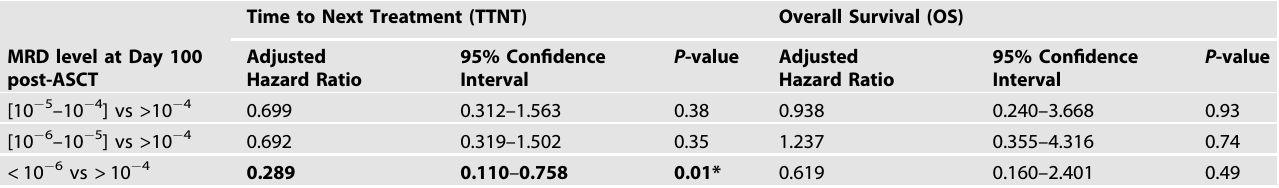
Table 2. Cox proportional hazard model for Time to Next Treatment (TTNT) and Overall Survival (OS) by Minimal Residual Disease (MRD) levels at day 100 Post-Autologous Stem Cell Transplant (ASCT). Time to Next Treatment (TTNT)